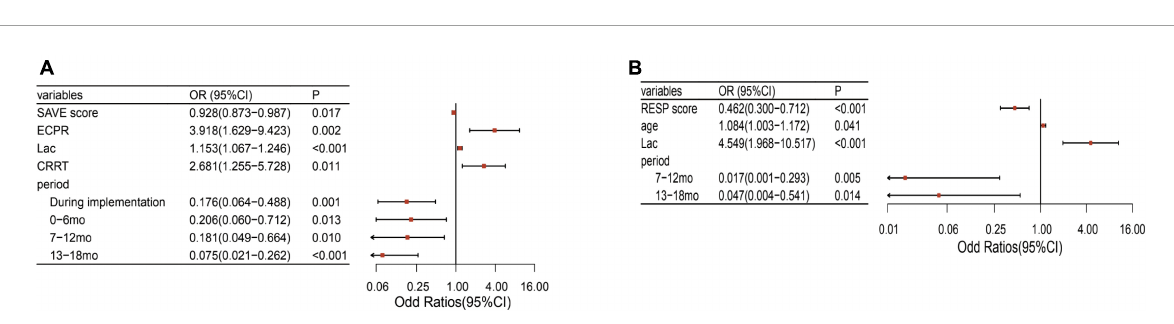
FIGURE3 Factors associated with mortality of V-A and V-V ECMO separately. (A) Factors associated with mortality of V-A ECMO. (B) Factors associated with mortality of V-V ECMO. V-A, venoarterial; V-V, venovenous; ECMO, extracorporeal membrane oxygenation; SAVE, Survival after VA-ECMO; RESP, respiratory ECMO survival prediction; Lac, lactate; mo, month; CRRT, Continuous renal replacement